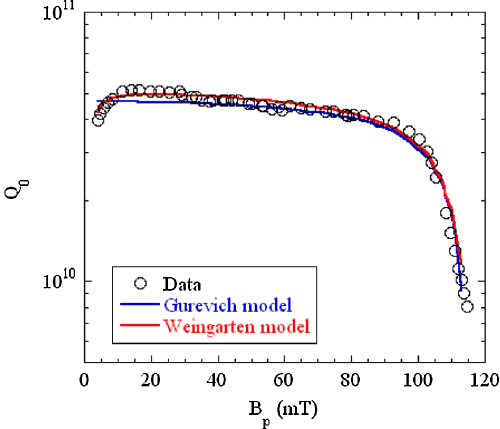
ð B Þ curve of a bulk Nb cavity FIG. 1. (Color) Typical Q p 0 limited by the Q drop fitted with Gurevich and Weingarten models. The data are from a CEBAF single-cell cavity (1.47 GHz) measured at 1.4 K